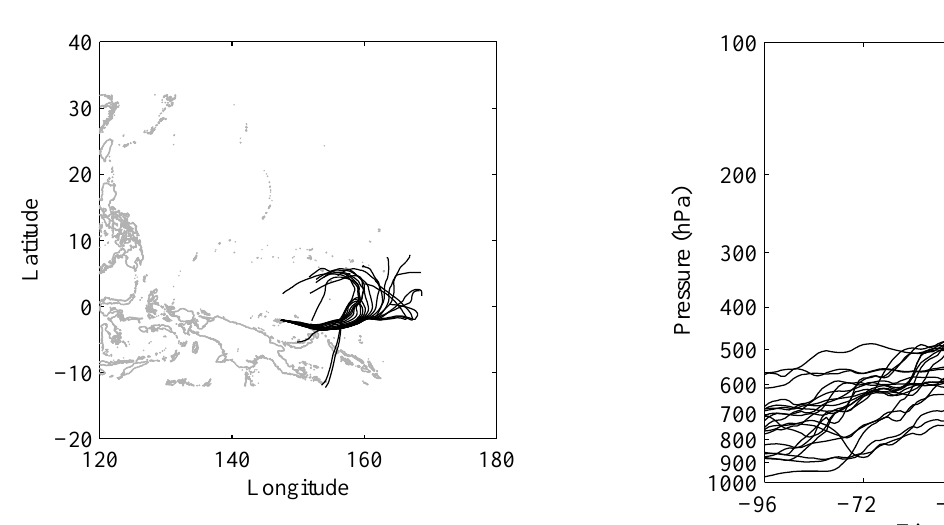
Figure 12. Map of the 21 HYSPLIT back-trajectories initiated from Manus Island at 100m intervals from 13 to 15km. The trajectories mostly come from the north-east of Manus Island, in the same loca- tion as the area of deep convection seen in Fig. 8.